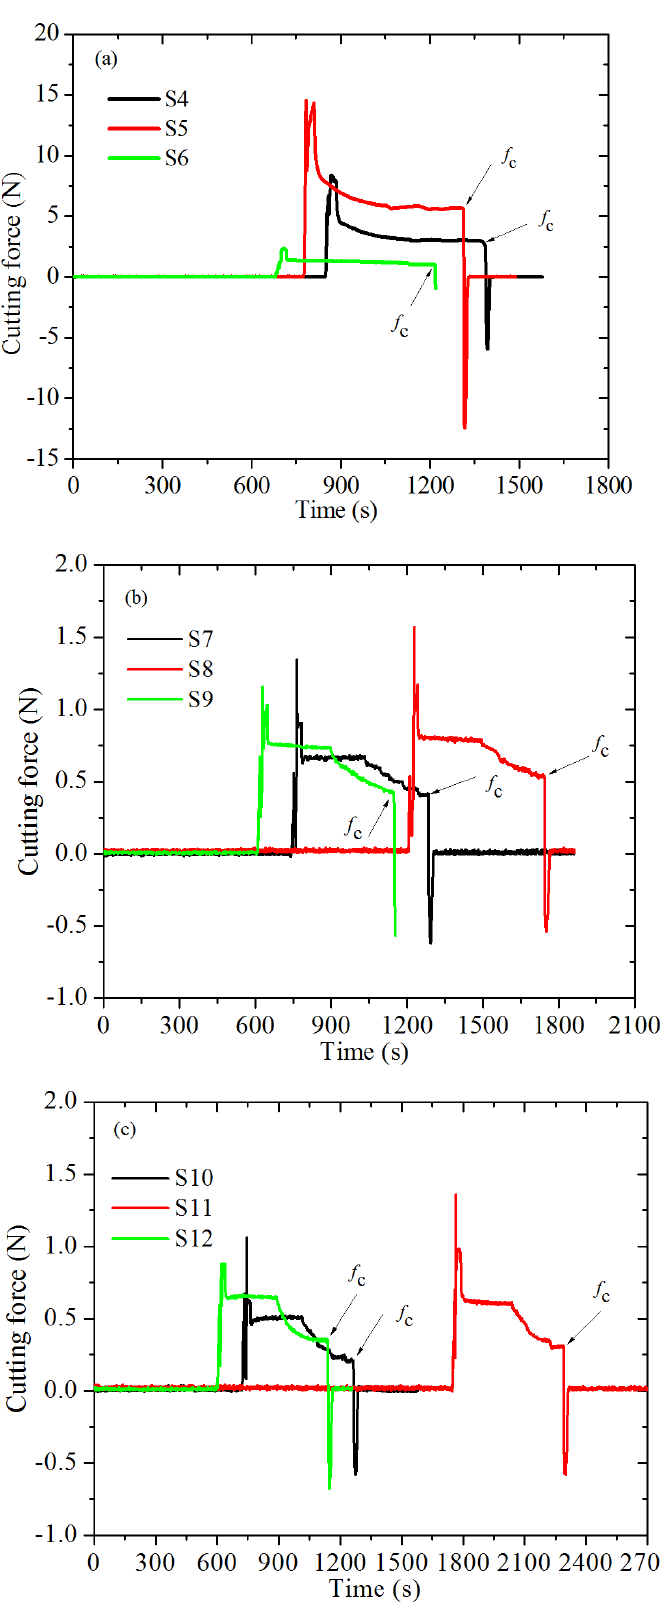
Figure 4. Schematic of cutting loading.